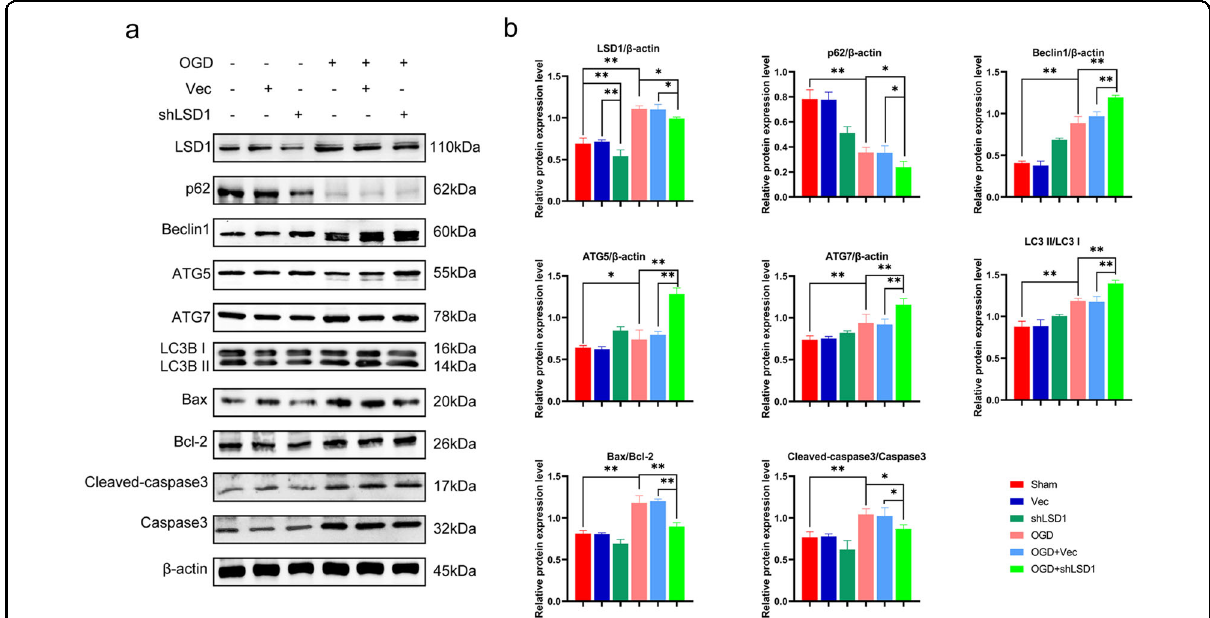
Fig. 4 Knockdown of LSD1 upgraded autophagy and downgraded apoptosis related proteins in vitro. a LSD1 Western blot analysis, post- injury autophagy, and apoptosis proteins. b Semi-quantitative detection of autophagy and apoptosis protein levels. One-way ANOVA and Tukey ’ s multiple comparisons test was used to compute p values for mean ± SD of three independent experiments. * p < 0.05; ** p <